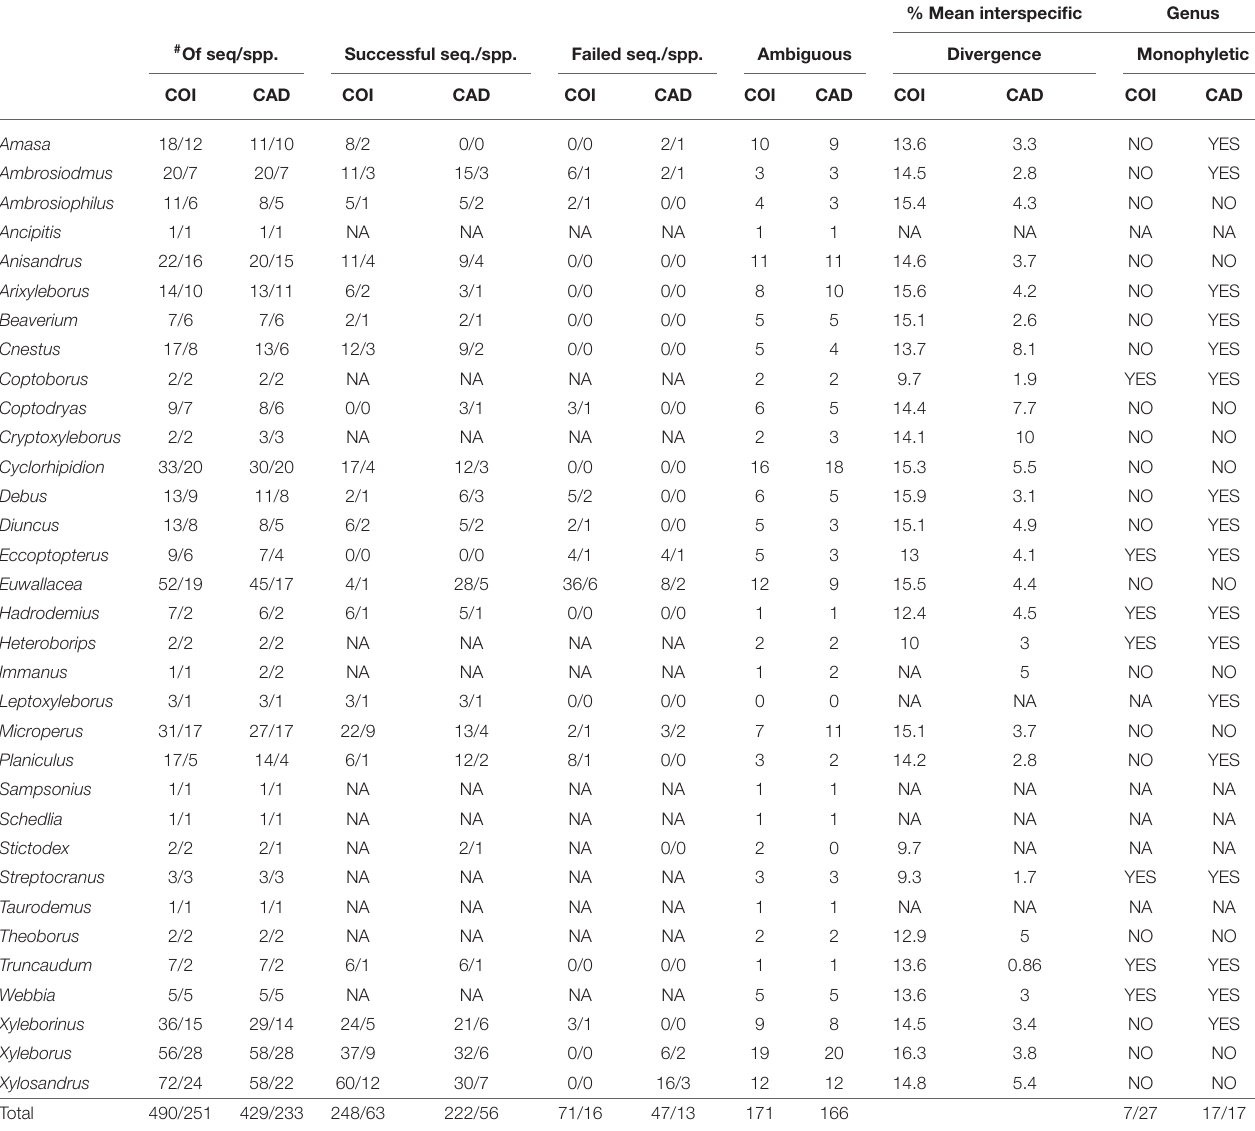
% Mean interspecific Genus